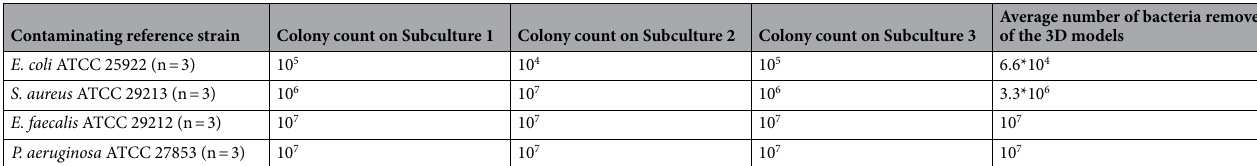
Table 1. Estimation of the bacterial load on the surface of the 3D models carried out directly after the 48-h-contamination protocol with four bacterial reference strain.